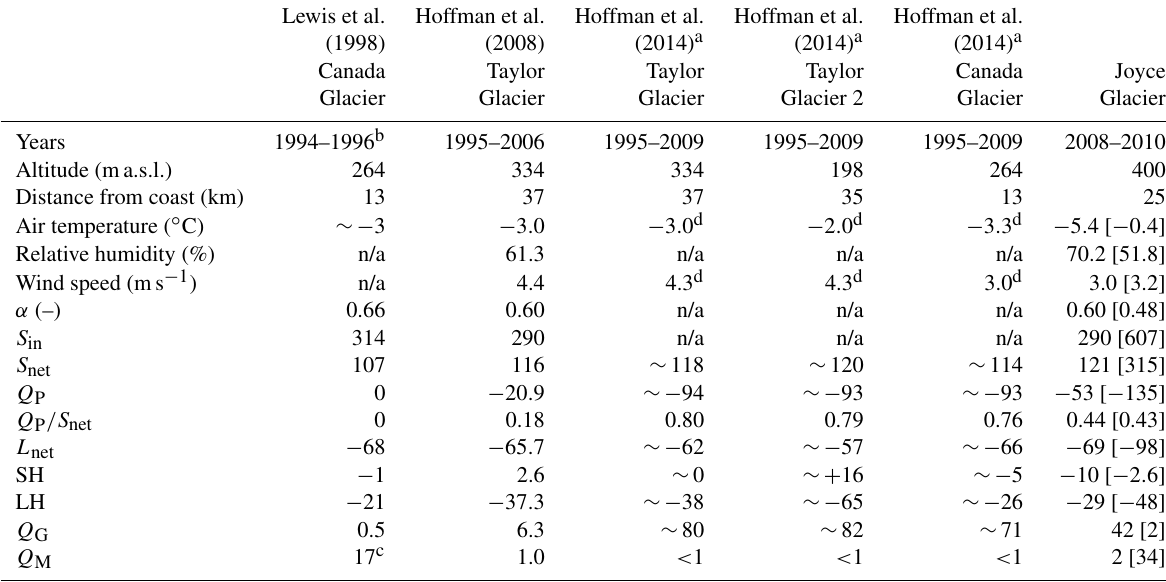
Table 2. Comparison of geographic characteristics, meteorological observations and SEB fluxes (Wm − 2 ) from glacial SEB studies in the MDV. The values represent averages for the December and January months within the study period, and for Joyce Glacier averages over only hours with surface melt are given in square